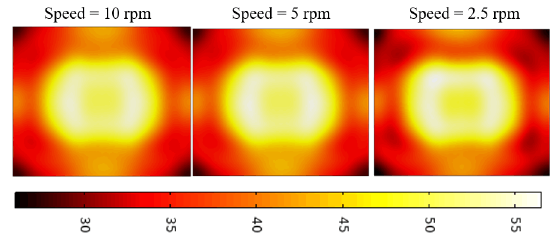
Figure 11. Simulated temperature distributions on the top surface of the cubic potato after microwave heating for 24 s with different rotation speeds (top view, unit: ℃ ).